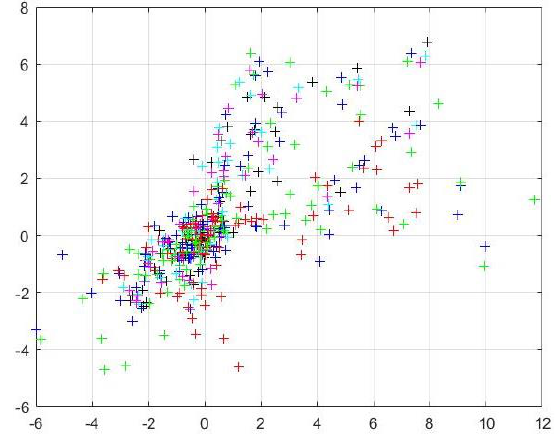
Figure 20. Reprojection error map.